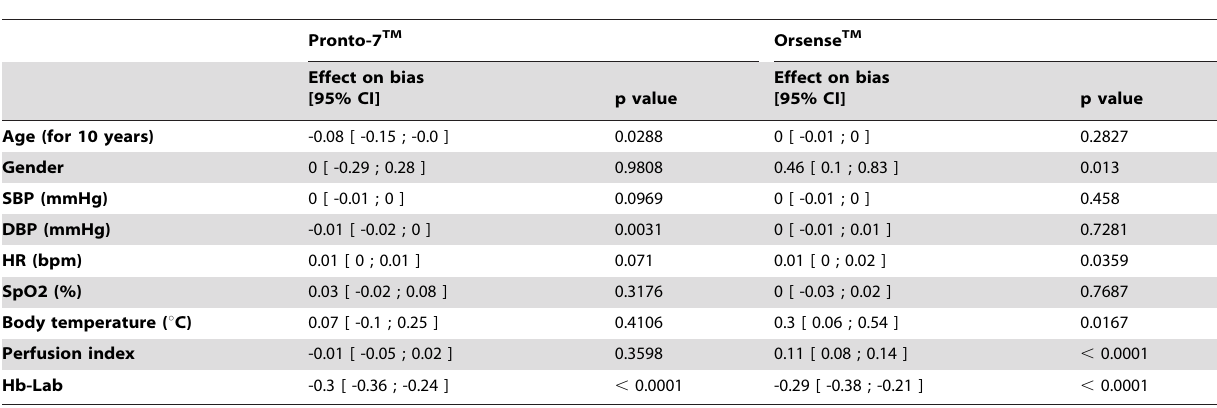
Table 3. Factors associated with the